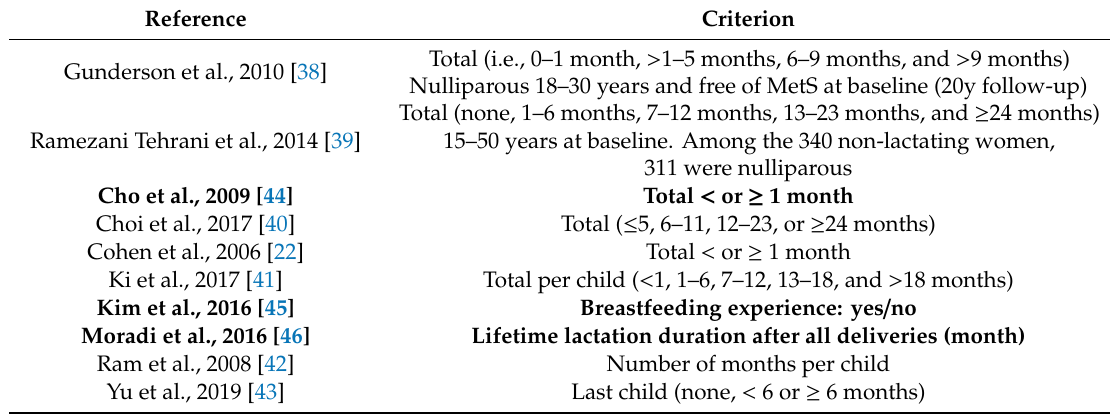
Table 4. Di ff erent criteria for the duration of lactation used in studies included in this review.